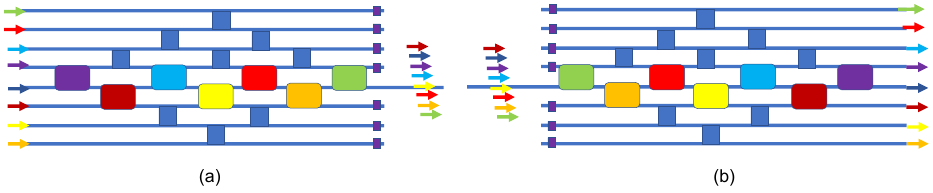
Figure 10. Block diagrams of the wavelength-division ( a ) 8 × 1 multiplexer and ( b ) 1 × 8 demulti- plexer.